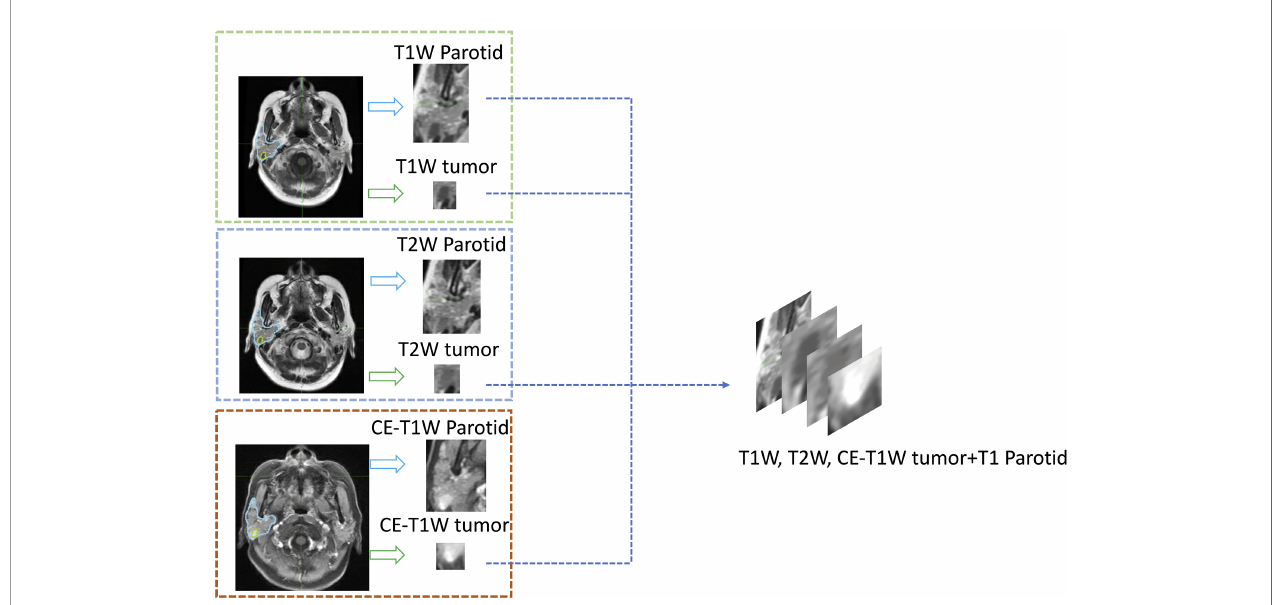
FIGURE 3 | An example of the four-channel input. All parotid glands and tumors were cropped from segmented MR images, and then the three series of tumor images and the T1-weighted parotid gland image were input into different channels of one image.